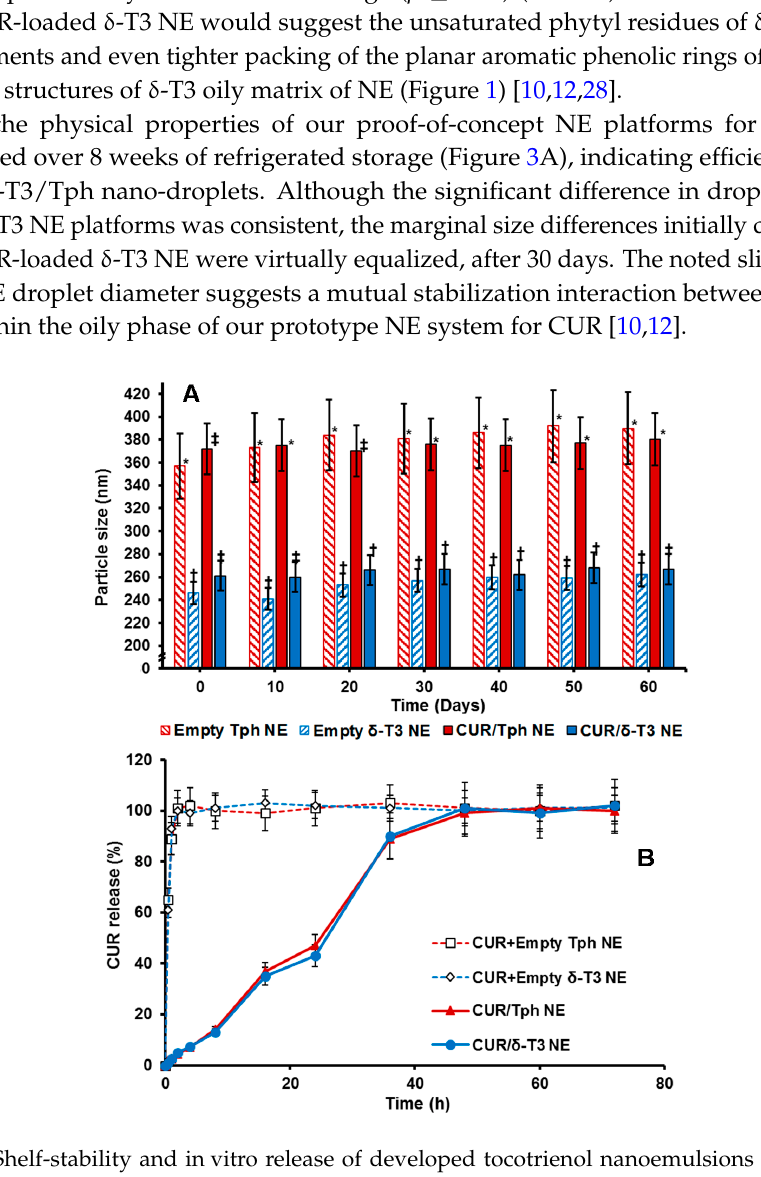
Figure 3. Shelf-stability and in vitro release of developed tocotrienol nanoemulsions of curcumin, showing ( A ) change in mean droplet size for drug-loaded and empty nanoemulsions over 60 days of cold storage; and ( B ) time-dependent release profile of encapsulated curcumin from nanoemulsions, in comparison to simple admixed preparations, under simulated sink conditions ( n = 4–5, mean ± SD, mean values denoted with unlike symbols are statistically different, p ≤ 0.05).